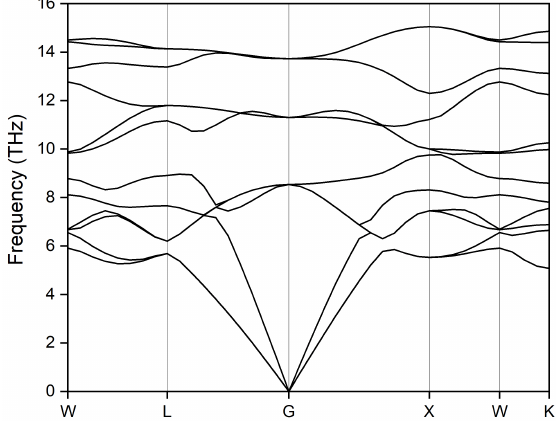
Figure 10. The photon dispersion spectrum of Ti 2 MnAl compound calculated at 50